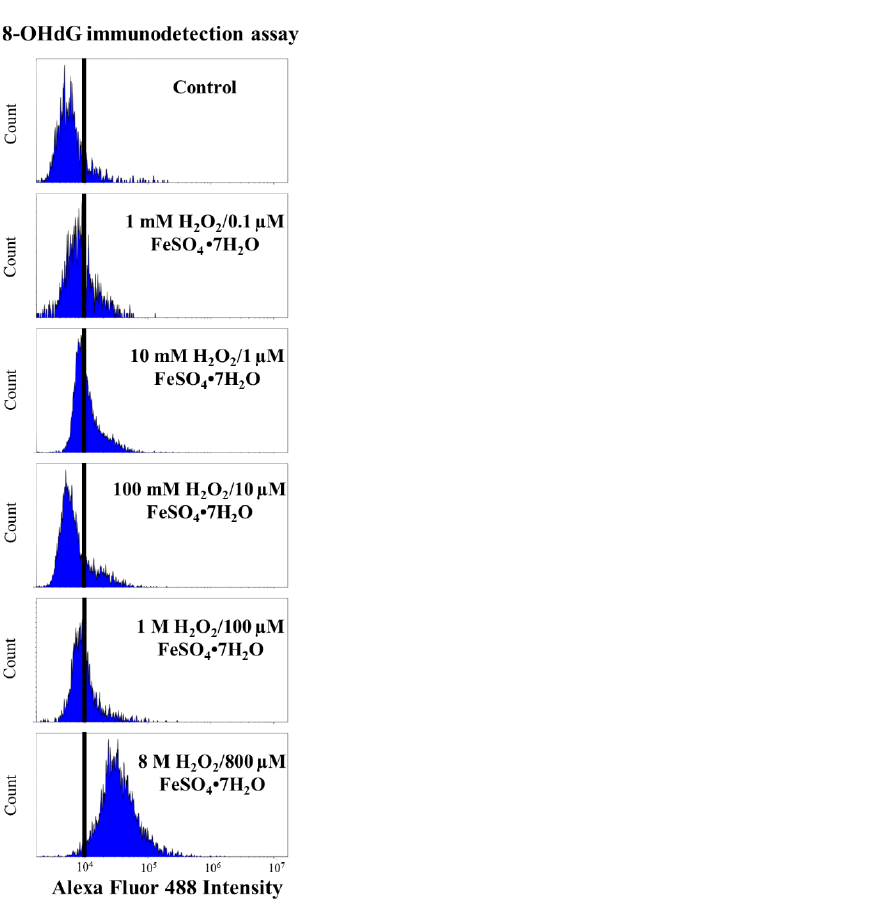
Figure 5. Effects of oxidant treatments on Sperm Chromatin Structure Assay (SCSA ® ) results. Mean of high DNA stainability (HDS %) ± standard error of the mean (mean ± SEM). a, b and c indicate significant differences ( p < 0.05). OS1 = 1 mM H 2 O 2 /0.1 µM FeSO 4 •7H 2 O; OS2 = 10 mM H 2 O 2 /1 µM FeSO 4 •7H 2 O; OS3 = 100 mM H 2 O 2 /10 µM FeSO 4 •7H 2 O; OS4 = 1 M H 2 O 2 /100 µM FeSO 4 •7H 2 O; and OS5 = 8 M H 2 O 2 /800 µM FeSO 4 •7H 2 O. Figure 6 shows the assessment of sperm chromatin status through SCSA ® . The green dots correspond to samples that were not treated with oxidant solution (control), and the red dots correspond to samples submitted to high exogenous oxidative stress (8 M H 2 O 2 /800 µM FeSO 4 •7H 2 O). The dots plotted to the right of the diagonal line have in- creased DFI, and the dots plotted above the horizontal line have increased HDS.